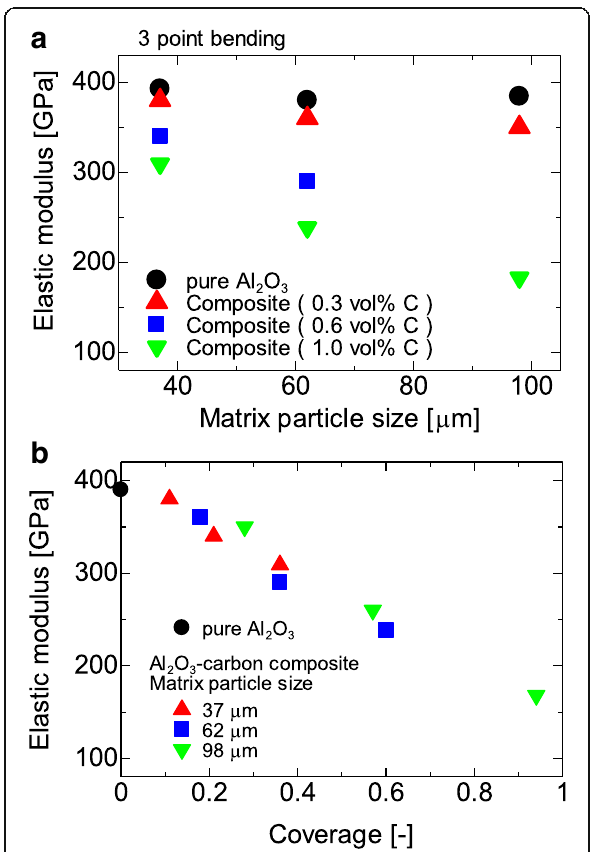
Fig. 5 Elastic moduli of CNP-Al 2 O 3 composites as a function of a matrix particle size and b CNP coverage on Al 2 O 3 particles